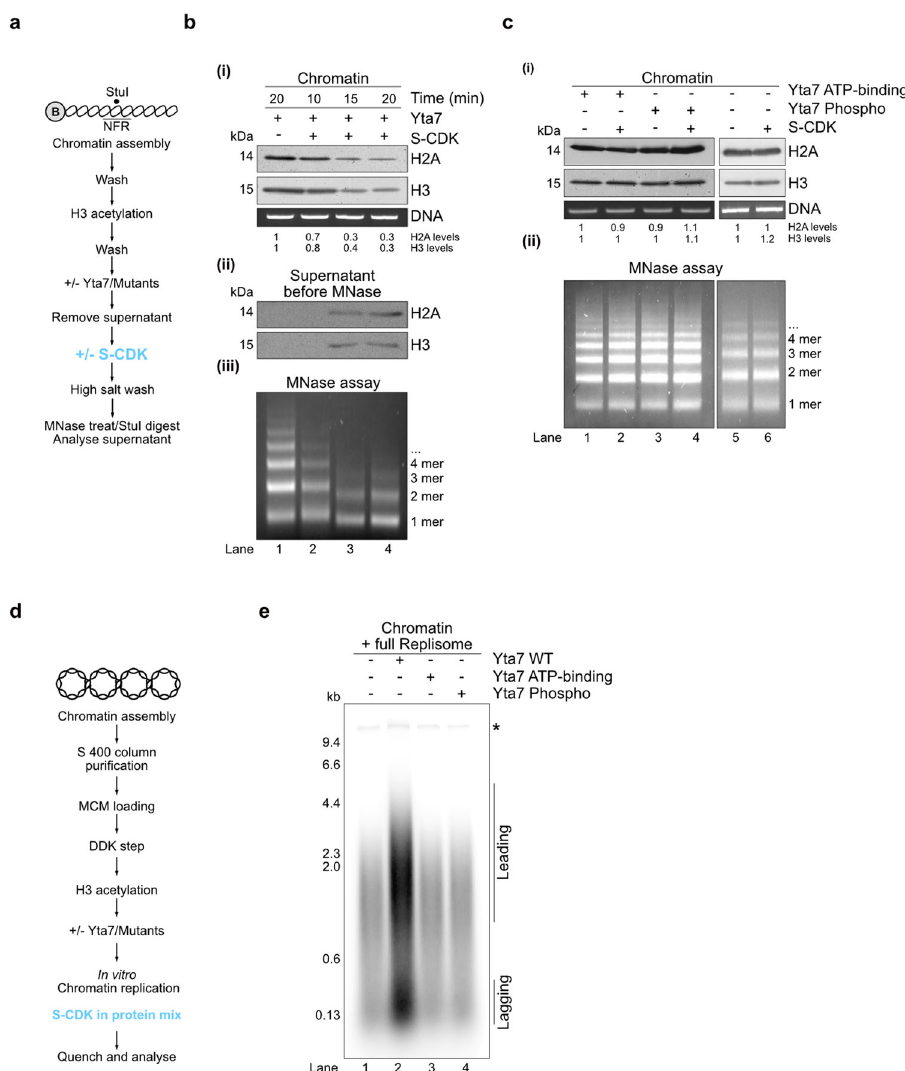
Fig. 5 S-CDK phosphorylation of Yta7 stimulates chromatin segregase function and chromatin replication. a Reaction scheme of the analyses of Yta7 function on chromatin. b Experiment as in Fig. 3a and b but with the inclusion of Yta7 phosphorylation by S-CDK. In addition, protein samples in the supernatant were analyzed by immunoblot after the fi rst high salt wash to detect proteins released after Yta7 treatment (ii). c Experiments as in a and b but using mutant Yta7 proteins and an S-CDK only control. d Reaction scheme of the in vitro chromatin replication assay including Yta7 and Yta7 mutants. e Effect of Yta7 on in vitro replication. Chromatin was assembled onto ARS1-containing 10.6 kb plasmid DNA in solution as described previously 5 . After puri fi cation of chromatinised templates via gel fi ltration, the replicative helicase Mcm2-7/Cdt1 (MCM) was loaded, phosphorylated by Dbf4-Dependent Kinase Cdc7 (DDK) and H3 was acetylated by pSAGA and acetyl-CoA followed by the addition of Yta7 and mutant versions. Chromatin replication reactions were initiated and included Ctf4, Dpb11, GINS, Cdc45, Pol ε , Mcm10, Sld2, Sld3/7, Pol α , Topo I, RPA, S-CDK, Csm3/Tof1, Mrc1, Pol δ , RFC, PCNA, and FACT/Nhp6. Reactions were stopped after 7 min and newly replicated DNA was visualized by the incorporation of [ α − 32 P] deoxycytidine triphosphate (dCTP) into nascent DNA. Products were separated through 0.8% alkaline agarose gels and visualized by phosphoimaging. Leading and lagging strands are visible because the assay does not include factors required for Okazaki fragment maturation. Asterisk indicates the end-labeling of nicked plasmid DNA. Shown are representative experiments, which have been biologically replicated three